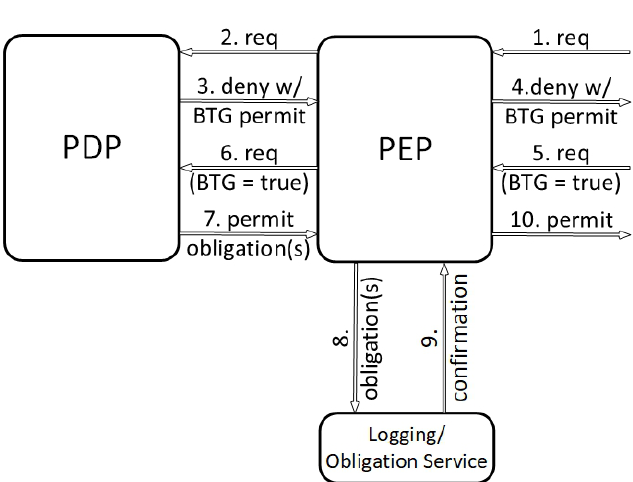
Figure 1. BTG request workflow. PDP is the policy decision point, and PEP is the policy enforcement point. Parentheses indicate the state of the system through condition variables, and steps 3, 4, 7, and 10 denote returned